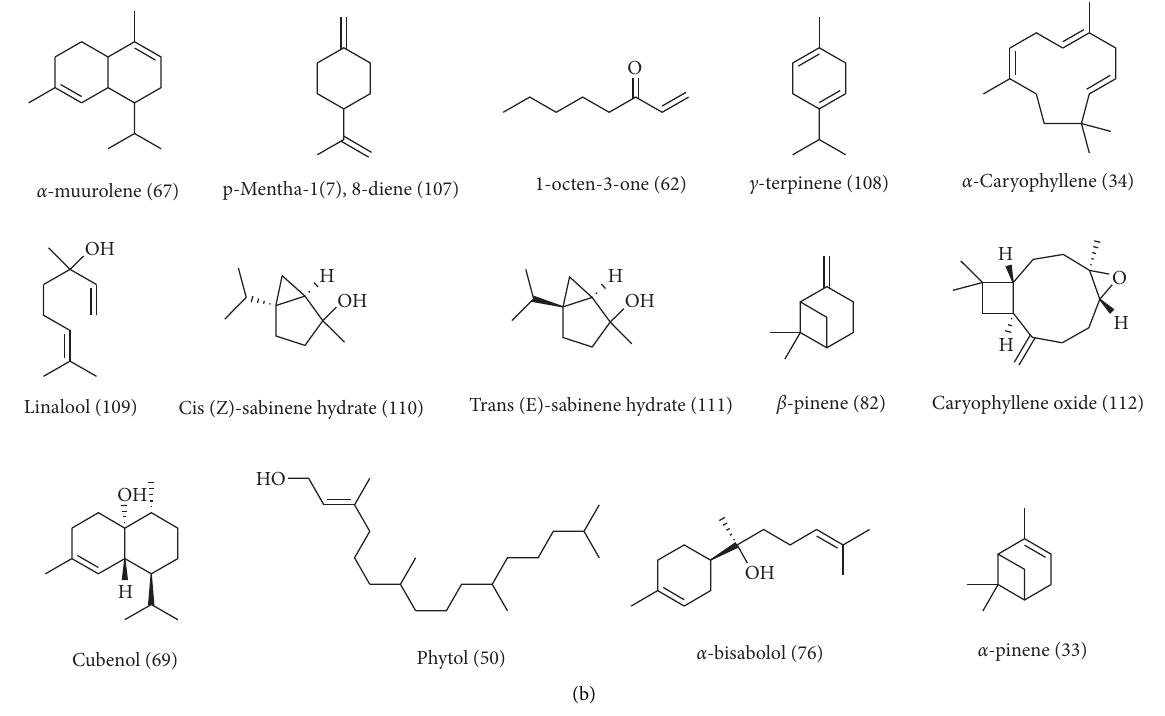
Figure 4: Structure of terpenoid compounds detected in C.